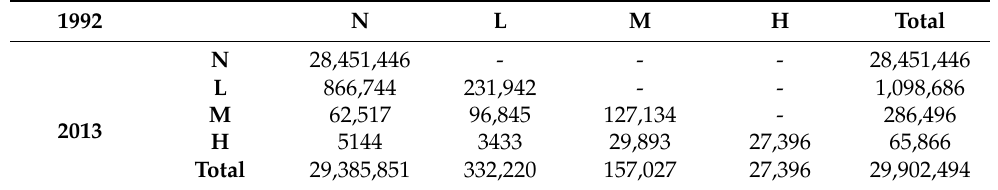
Table 4. Transition matrix of different nighttime lighting types between 1992 and 2013 across Africa.